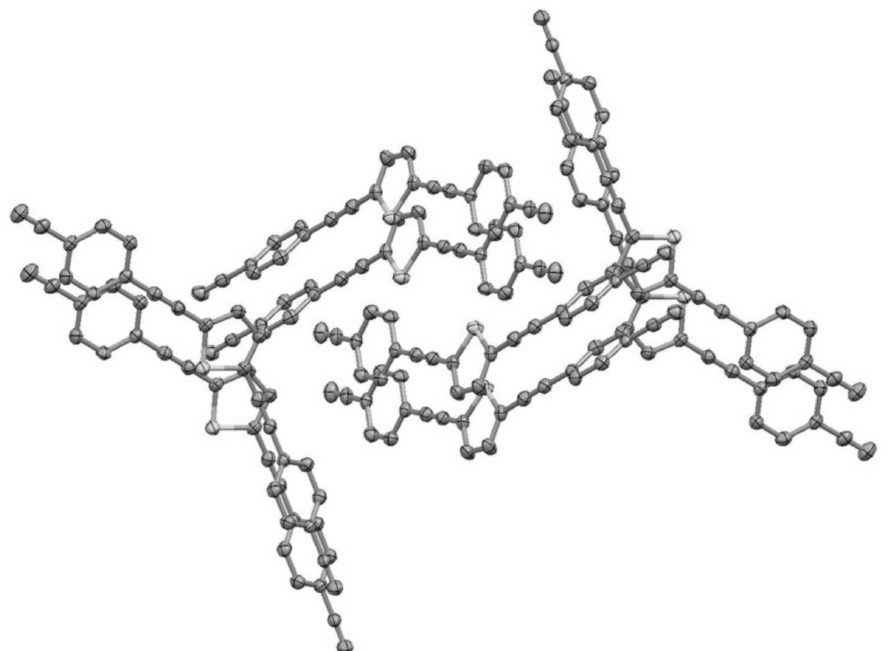
Figure 2 The packing of (I), viewed along the b